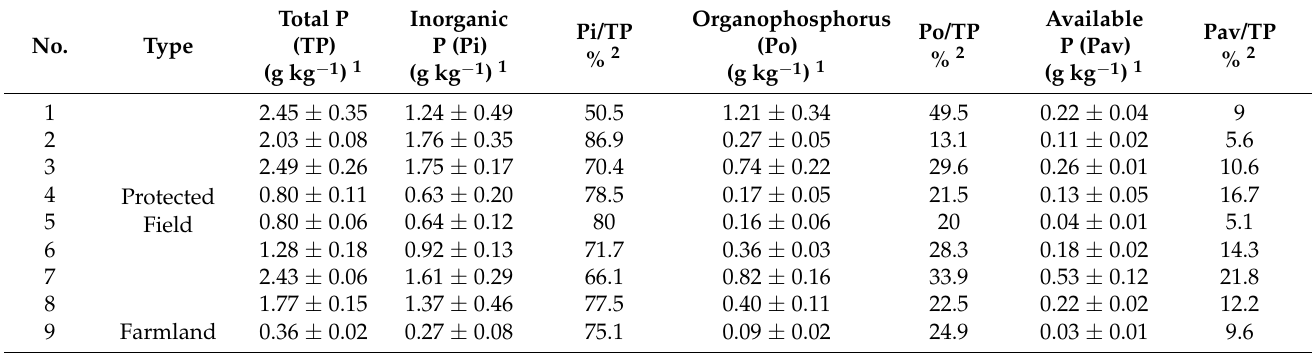
Table 2. Phosphorus composition of the top 20 cm of soil collected from protected